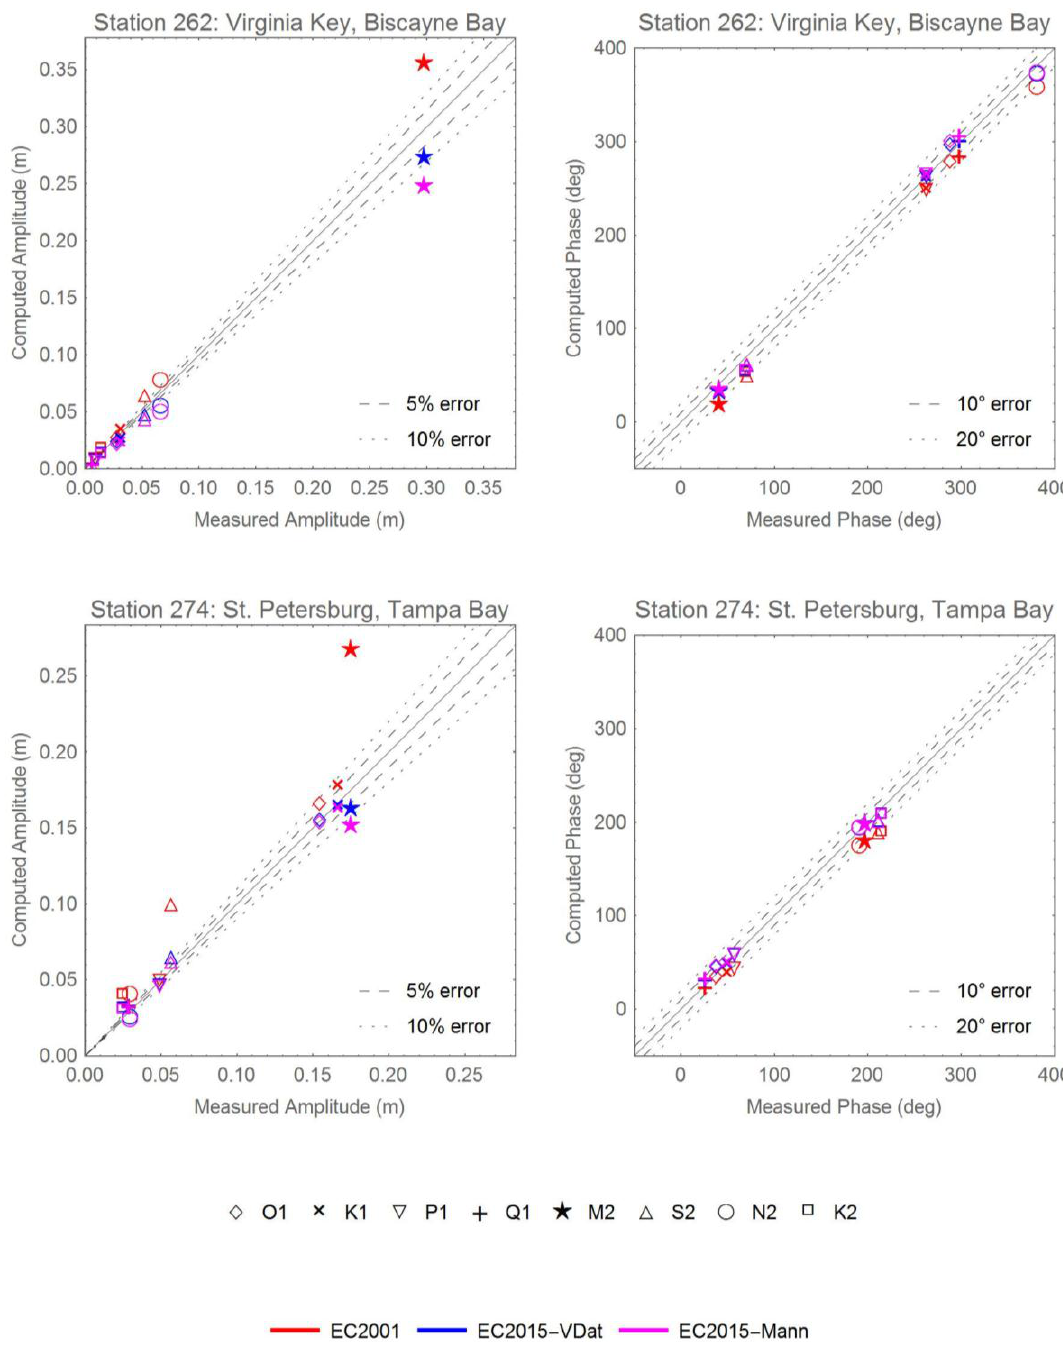
Figure B2. Scatterplots of computed versus measured harmonic data for representative stations along the Florida coast.